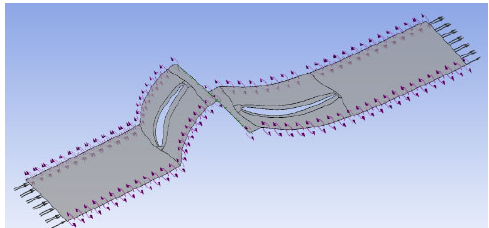
Figure 5. Computational domain of rotor and stator.